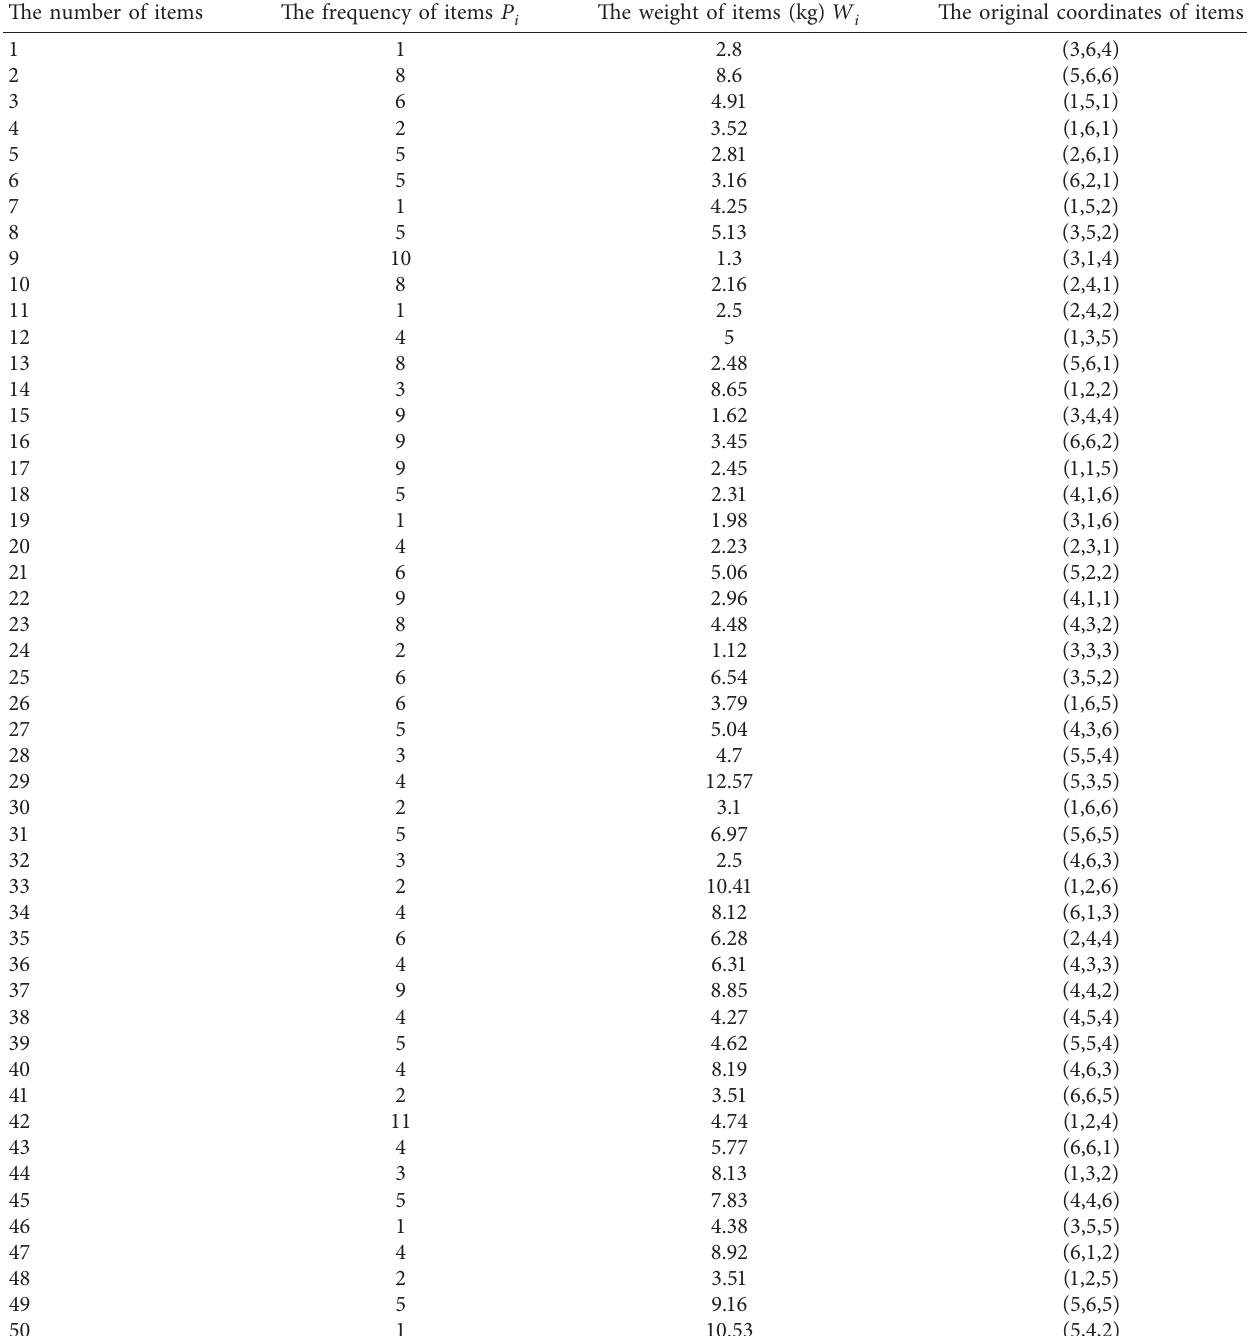
Table 1: Data of the